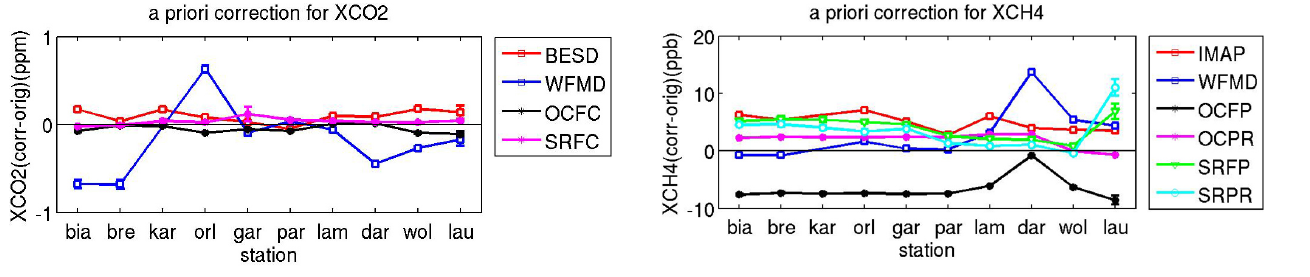
Figure 1. Mean a priori correction (XCO 2 corrected – XCO 2 orig- inal), in ppm, on the XCO 2 result, per station.